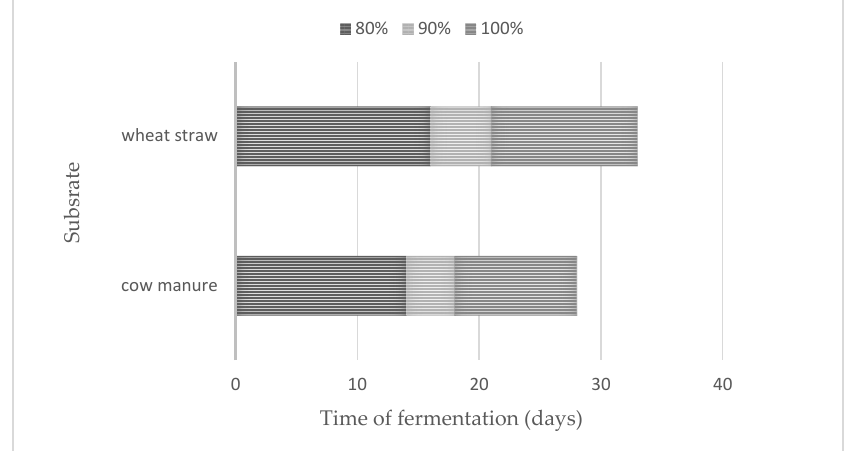
Figure 6. Time required for 80, 90, and 100% of total methane production for the analyzed materials.